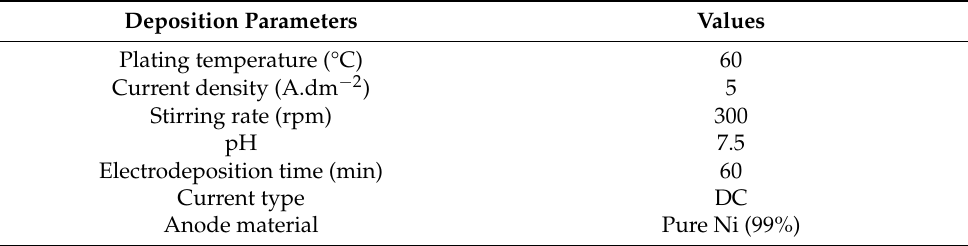
Table 3. Electrodeposition